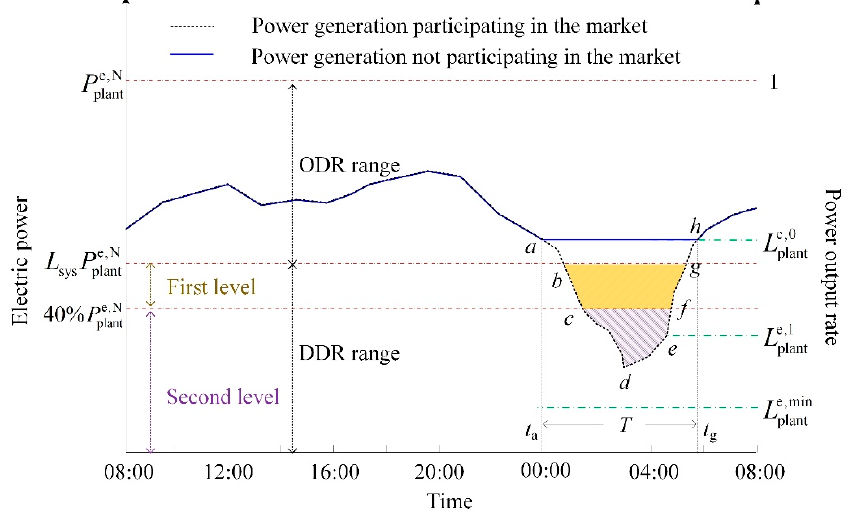
Figure 2. Reimbursement rule for real-time Deep Down-regulation (DDR).